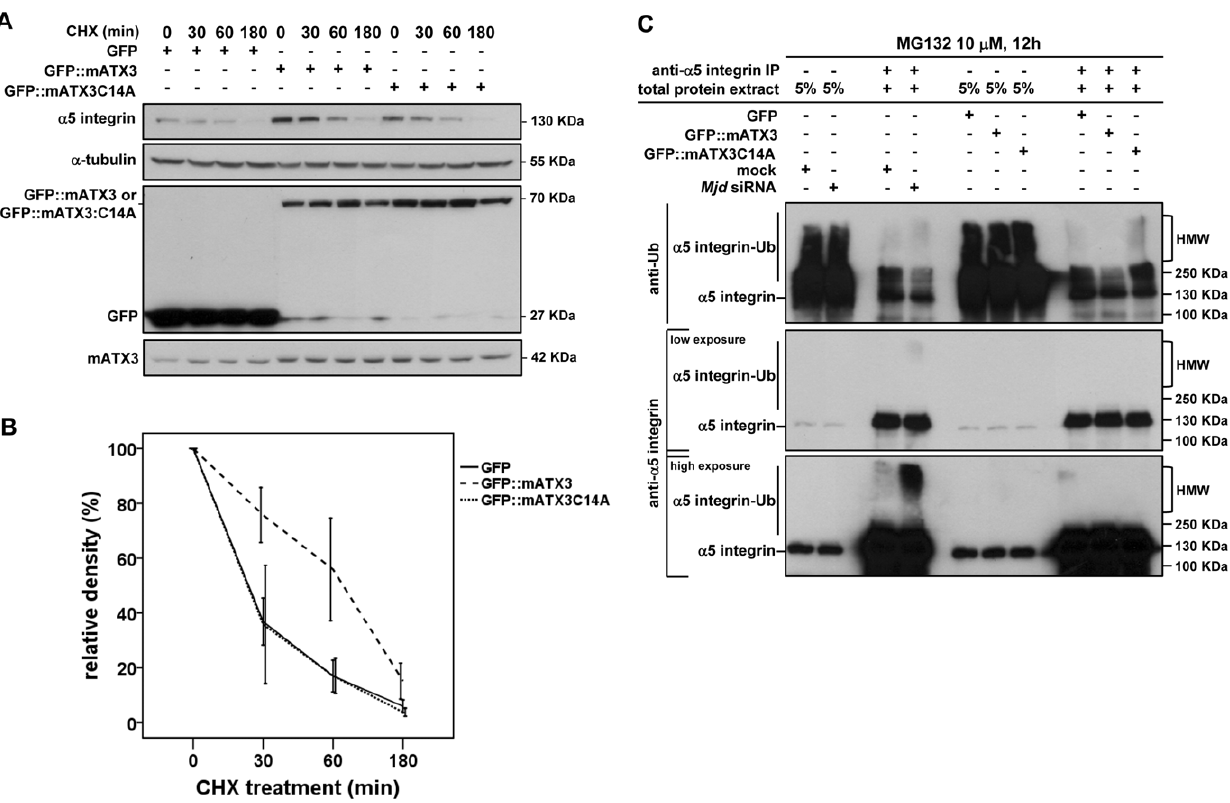
Figure 6. Ataxin-3 stabilizes a 5 integrin subunit and represses its proteolysis. (A) Effect of mATX3 overexpression in the half-life of a 5 integrin subunit. C2C12 cells were transfected with the pEGFP:Mjd (GFP::mATX3), the pEGFP:MjdC14A (GFP::mATX3C14A) or the pEGFP-C1 (GFP)- empty plasmids, and after 48 hrs cells were treated with cycloheximide for 0, 30, 60 or 180 min. Whole cell extracts were collected for these time points and analyzed for the levels of endogenous a 5 integrin subunit by immunoblotting. The overexpression of GFP::mATX3, but not the of GFP or the catalytic mutant GFP::mATX3C14A, was shown to stabilize the levels of a 5 integrin subunit. (B) The graph represents the relative amounts of a 5 integrin subunit in GFP, GFP::mATX3 and GFP::mATX3C14A overexpressing cells at various cycloheximide treatment times. The levels of endogenous mATX3 were similar in all the transfections. The results were normalized for a -tubulin and correspond to the average of three independent transfections 6 SEM (error bars). (C) Denature-renature immunoprecipitation of a 5 integrin subunit from Mjd siRNA, mock, GFP, GFP::mATX3, or GFP::mATX3C14A transfected C2C12 cells treated with the proteasome inhibitor MG132 at 10 m M, during 12 h. The immunoprecipitated forms of a 5 integrin subunit were separated in a SDS-PAGE gel and blotted for ubiquitin and a 5 integrin subunit (low and high exposure of the same blot). An increase of ubiquitinated forms of a 5 integrin subunit was detected in mATX3-depleted cells. Cells overexpressing GFP::mATX3 showed a reduction in ubiquitinated a 5 integrin subunit forms. No decrease of these species was observed in cells overexpressing the catalytic mutant